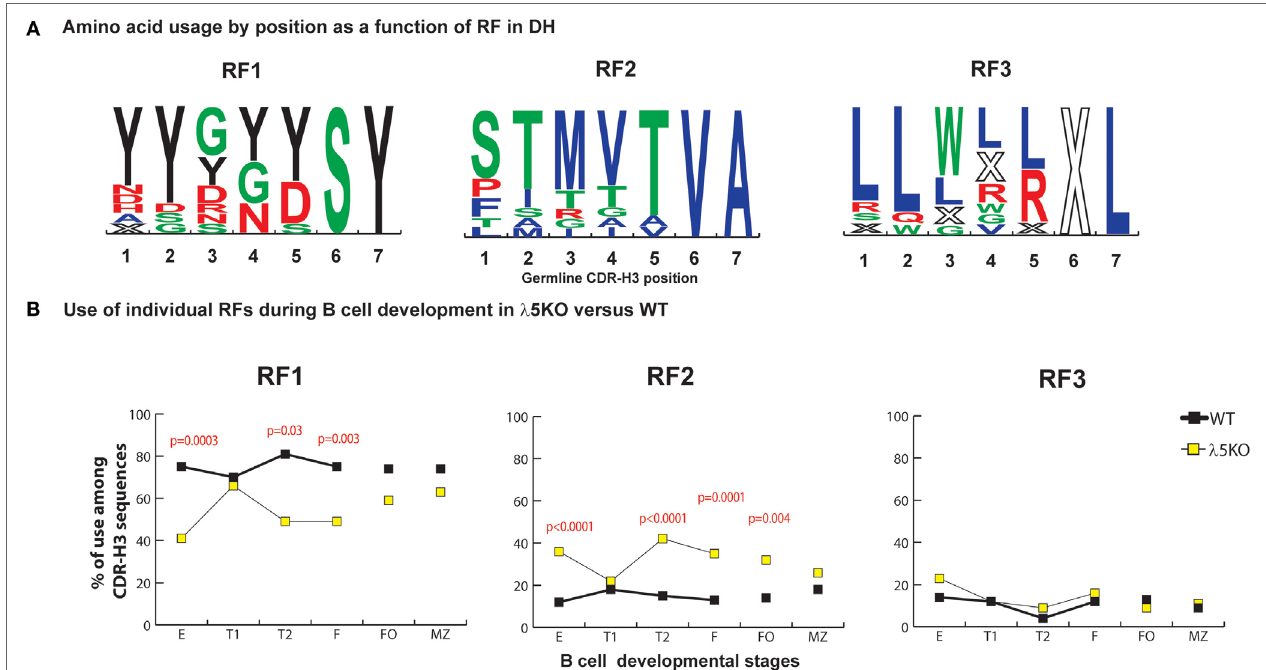
FigUre 1 | Differences in the use of D H reading frames (RFs) in λ 5KO versus wild-type (WT). (a) Amino acids in rank order according to their expression (position by position) from total germline D H as a function of RF utilization. Charged amino acids are colored red, hydrophilic amino acids are colored green, hydrophobic amino acids are colored blue, and tyrosine is colored black. The size of the single letter is proportional to its prevalence. (B) The difference in RF usage through successive B cell developmental stages. Immature fraction (E) and mature recirculating fraction (F) cells were identified using Hardy’s scheme (12). Transitional (T1), (T2), and follicular (FO) B cells were identified using Allman’s scheme (9). Marginal zone (MZ) B cells were identified using Loder’s scheme (13). The p -values for differences that achieved statistical significance ( p ≤ 0.05) are shown. CDR-H3 sequences were unique and obtained from at least six mice per